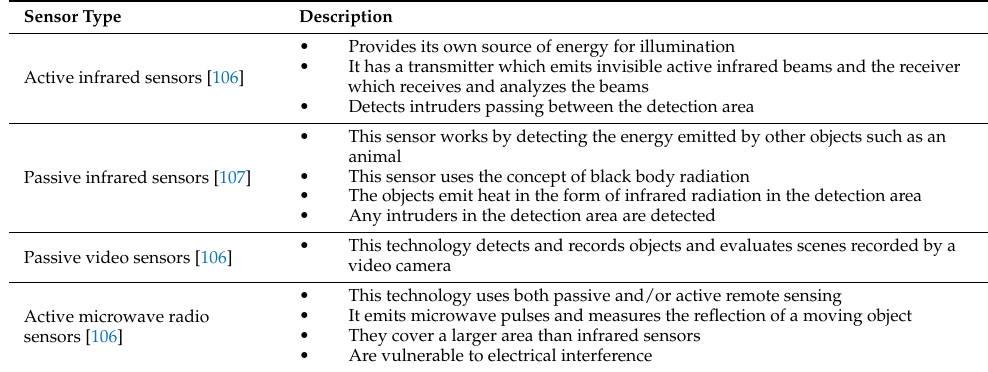
Table 4. Description of sensors deployed in area cover